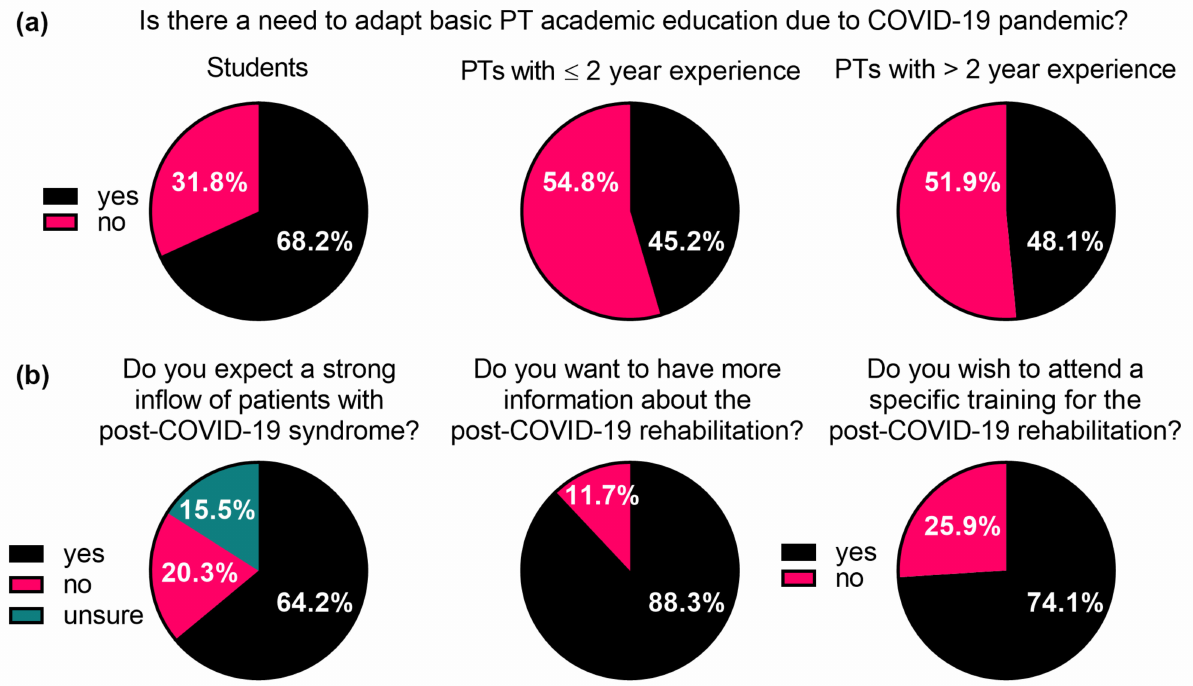
Figure 2. ( a ) Perception of physiotherapy students and physiotherapists regarding the adaptation of academic education due to the COVID-19 pandemic. ( b ) Assessment of participants’ expectations as to patient inflow as well as their interest in attending specific post-COVID-19 rehabilitation training. PT, physiotherapy; PTs, physiotherapists. See also Supplementary PDF